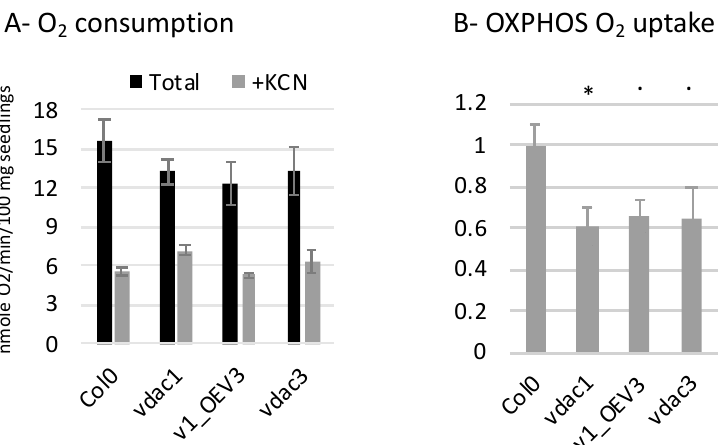
Figure 5. O 2 uptake in seedlings. The oxygen consumption was measured on seedlings (30–40 mg) with an oxygen electrode system. After a first recording of 6 min, KCN, which blocks OXPHOS activity, was added. ( A ) Total oxygen consumption, and after KCN addition (nmol O 2 / min / 100 mg seedlings) (mean values of 3–5 assays). ( B ) OXPHOS O 2 uptake was determined by subtracting residual KCN consumption to total, and expressed relatively to Col0. Student’s test p -value: · between 5% and 10%, * between 1% and 5%. Error bars, SEM.